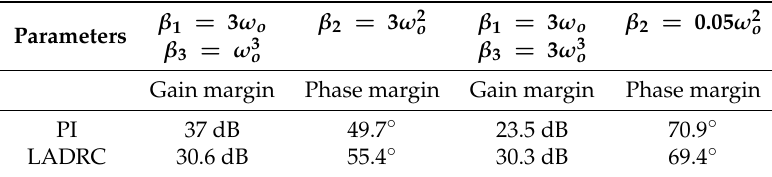
Table 1. Phase margin and gain margin of PI and